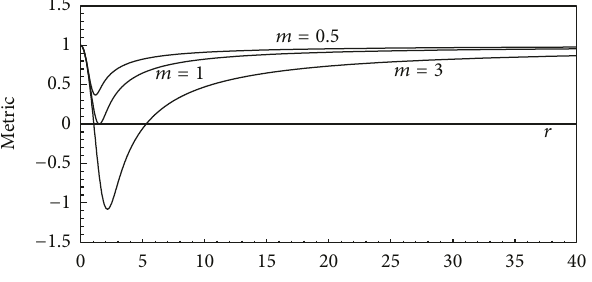
Figure 1: Typical behavior of spherical metric function 𝑔(𝑟) . Here 𝑚 is the mass parameter 𝑀 normalized to its certain critical value which specifies the double-horizon